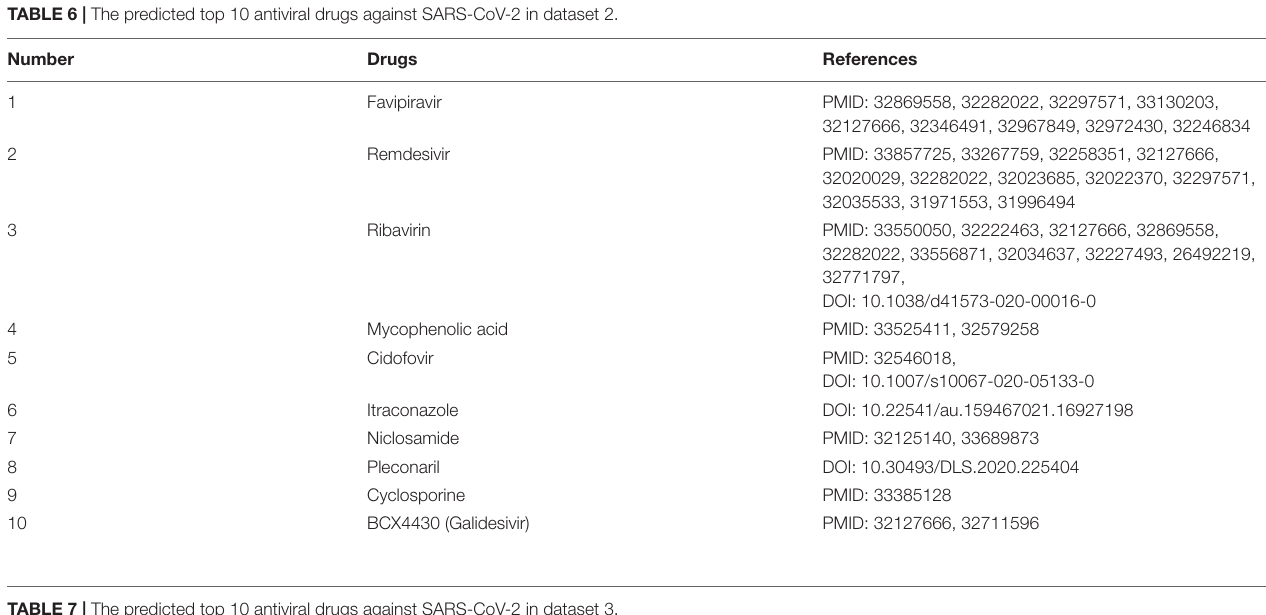
TABLE 6 | The predicted top 10 antiviral drugs against SARS-CoV-2 in dataset 2.